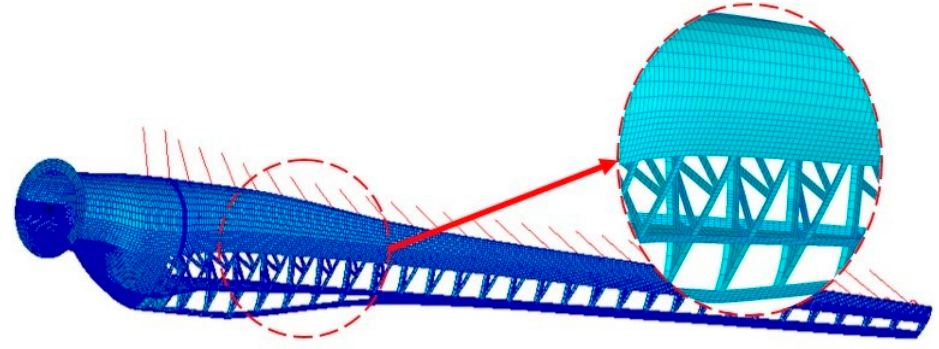
Figure 10. The 3D blade finite element model.